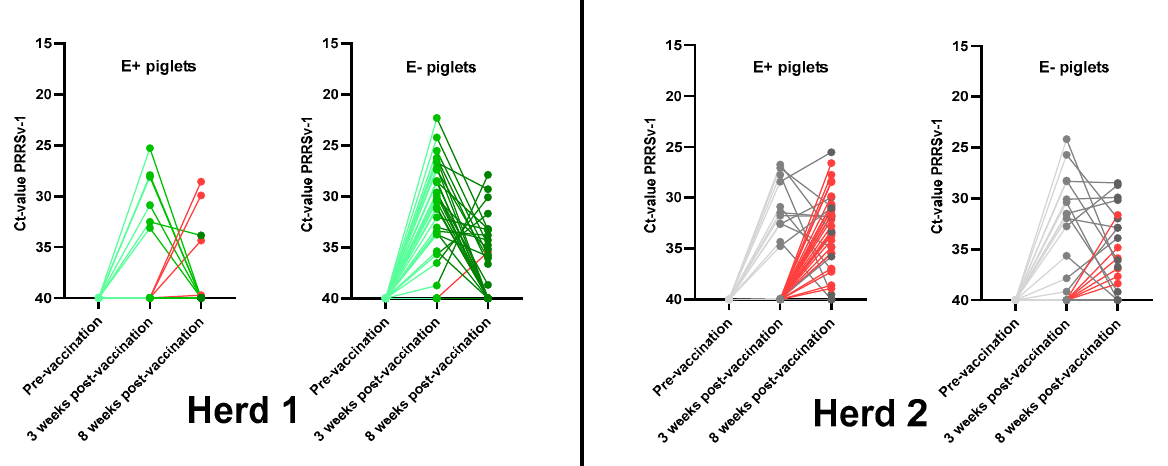
Figure 4. PRRSv vaccine viremia in PRRSv-vaccinated piglets born from PRRSv-vaccinated seropositive sows (E+ piglets) and PRRSv-vaccinated seronegative sows (E − piglets) in two Belgian farrow-to-finish herds. Piglets in herd 1 ( left ) were intramuscularly PRRSv-vaccinated at 3 weeks of age with the Porcilis ® vaccine. Piglets in herd 2 ( right ) were intramuscularly PRRSv-vaccinated at 4 weeks of age with the Unistrain ® vaccine. Results are shown as dots for the individual Ct-values at pre-vaccination and at 3 weeks and 8 weeks post-vaccination, with lines connecting the Ct-values for each piglet over time. Red lines indicate a secondary vaccine exposure—piglets that became PCR-positive between 3 weeks and 8 weeks post-vaccination. Piglets testing negative in PCR were given a Ct-value of 40.